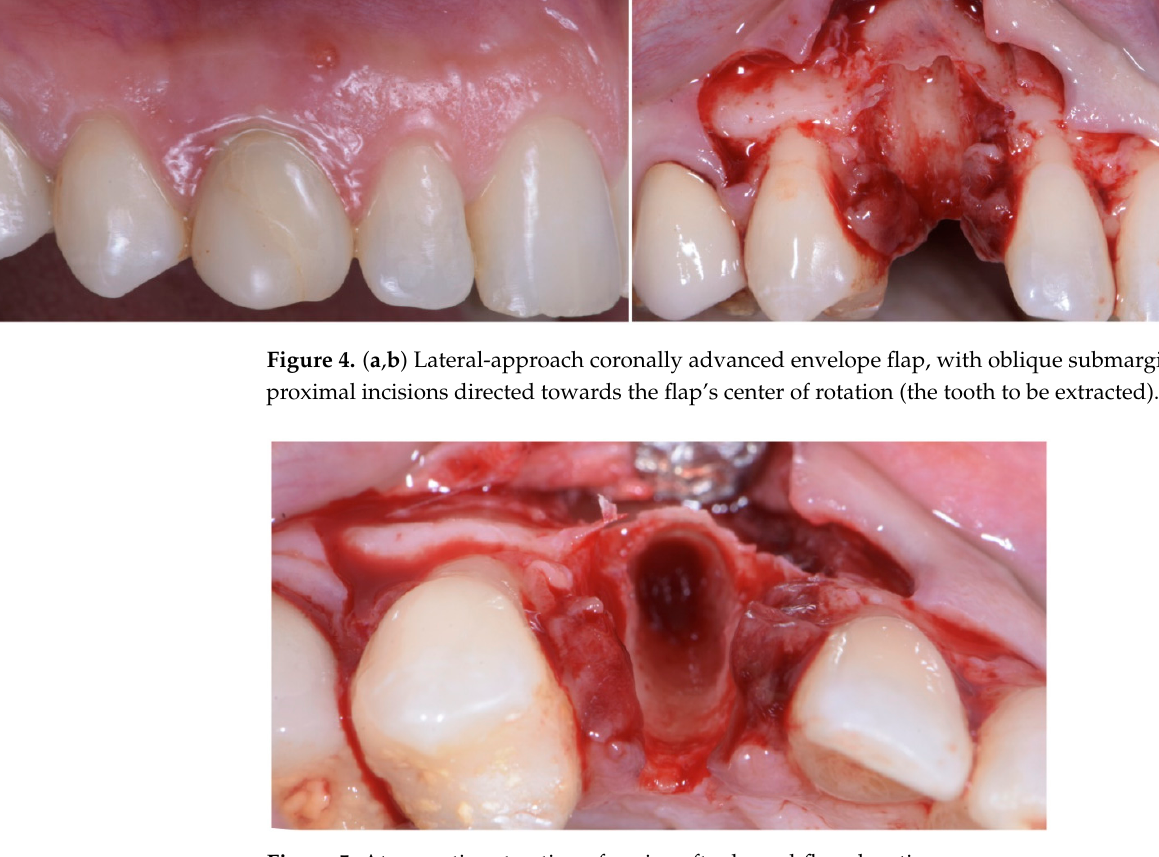
Figure 5. Atraumatic extraction of canine after buccal-flap elevation.